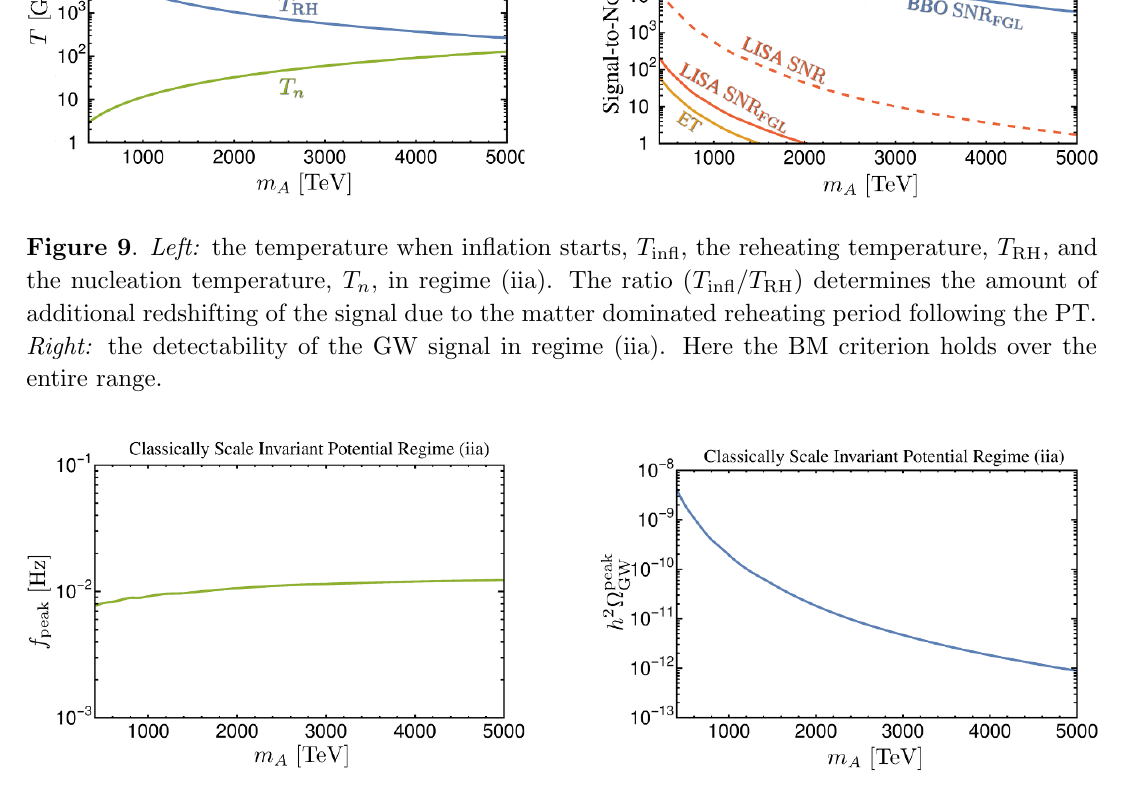
Figure 10 . Left: the peak frequency in regime (iia). Right: the peak amplitude in regime (iia). In this regime (cid:11) (cid:24) O (10 15 ) and (cid:12)=H (cid:25) 7 largely independent of m A